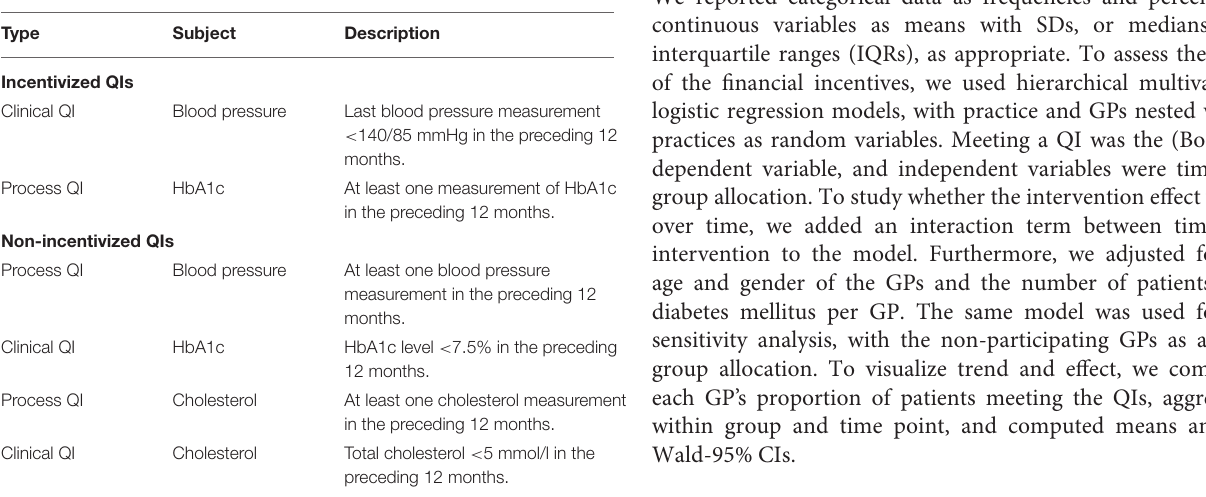
TABLE 1 | Quality indicators are used to assess primary and secondary